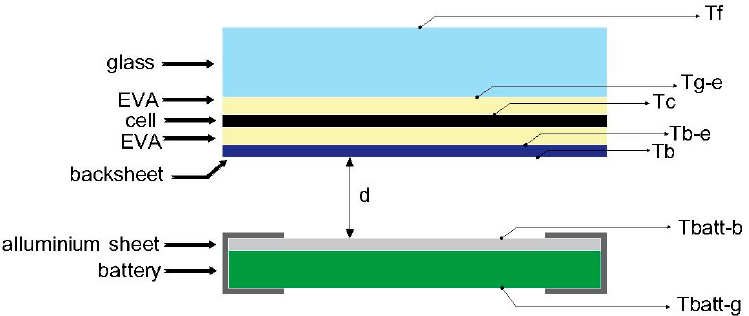
Figure 3. Battery and PV module layers. T is temperature; b is backsheet; e is ethylene vinyl acetate (EVA); f is front side; g is ground and batt is battery.